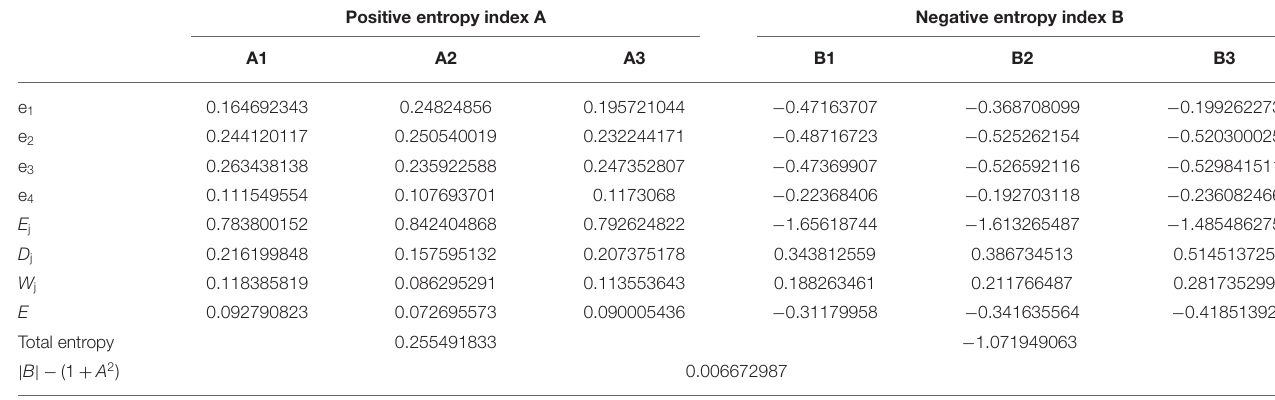
TABLE 6 | Entropy values and weight of the index.